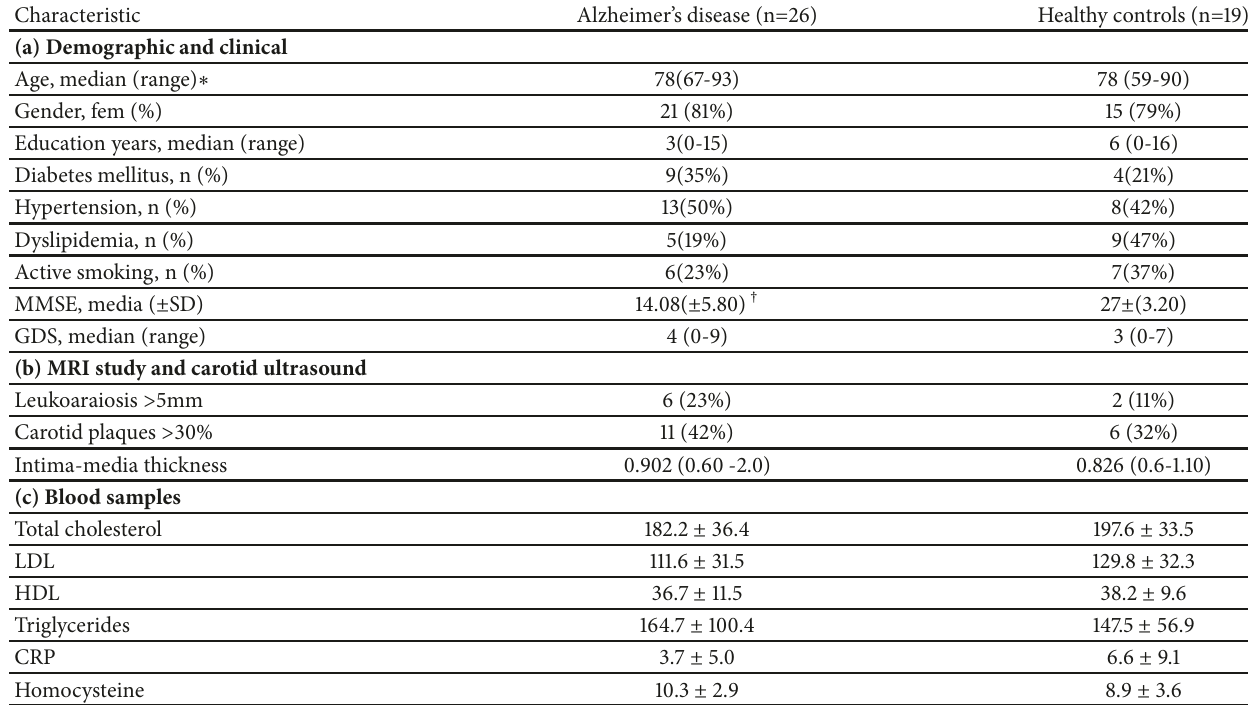
Table 1: Demographic, clinical, imaging, and blood sample characteristics of Alzheimer’s disease and healthy control participants.